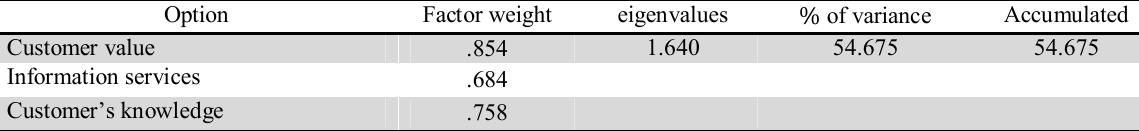
The summary of factors associated with customer oriented strategy